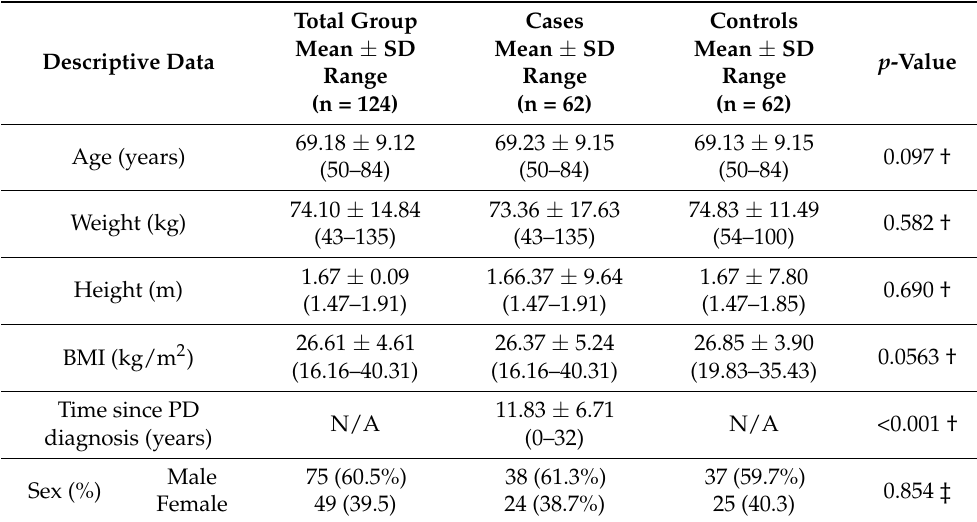
Table 1. Descriptive data of the Parkinson patients and healthy matched-paired controls.